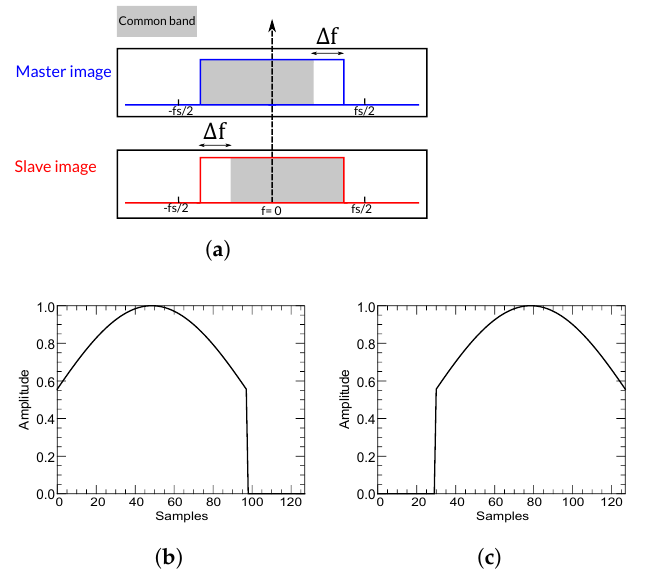
Figure 9. Band-pass spectral filtering of master and slave images. A spectral displacement of 30 samples is assumed. ( a ) Master and slave images’ spectra. ( b ) Spectral shape of the band-pass filter used for master image. ( c ) Spectral shape of theband − pass filter used for slave